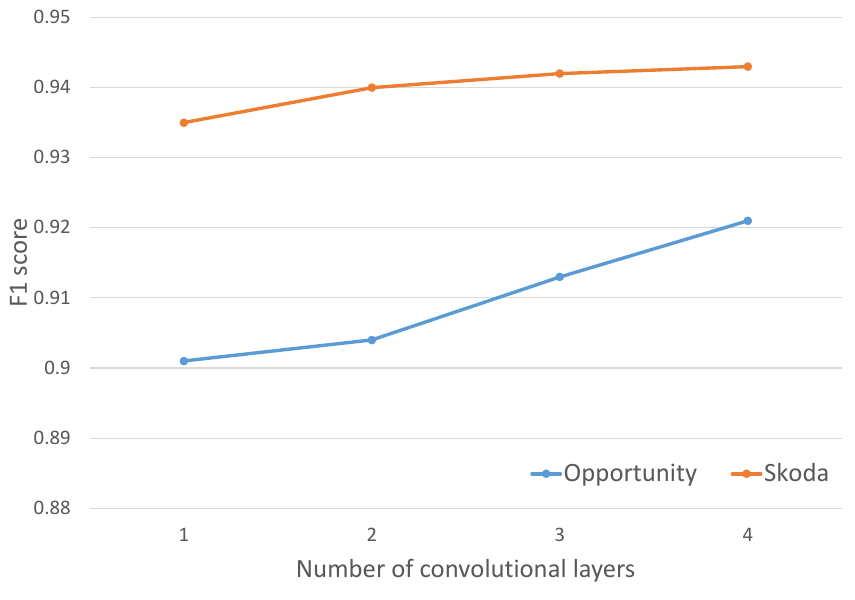
Figure 8. Performance of Skoda and OPPORTUNITY (recognizing gestures and with the Null class) datasets with different numbers of convolutional